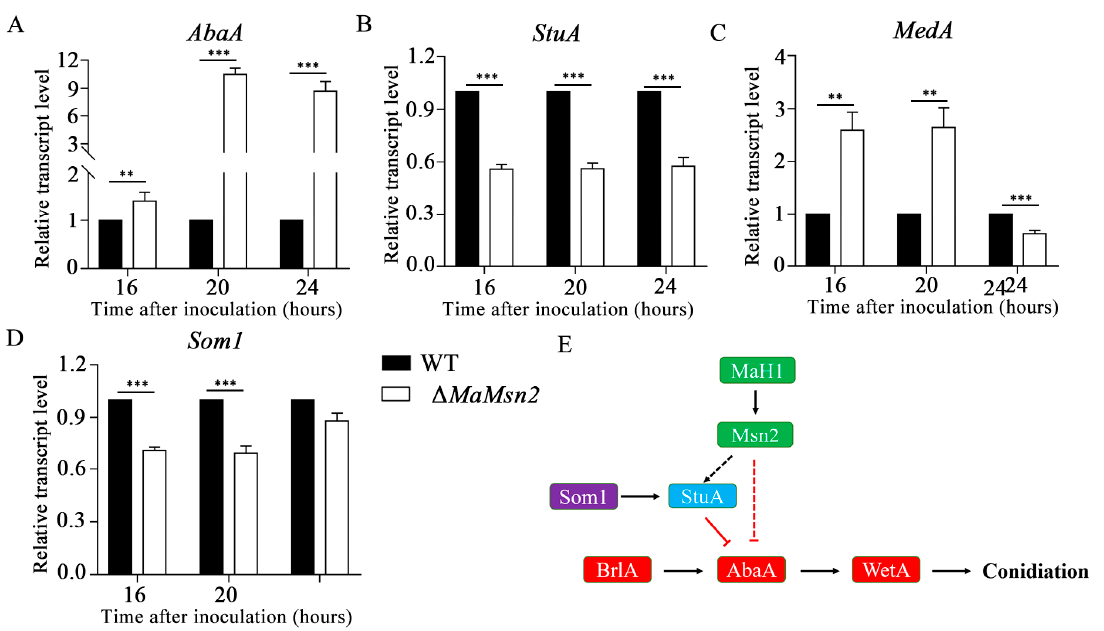
Figure 8. MaMsn2 regulates AbaA and StuA . ( A – D ) The relative expressions of conidiation-related genes in ∆ MaMsn2 ( t -test, ** : p < 0.01, *** : p < 0.001). ( E ) Genetic model for MaH1 – MaMsn2 in conidiation pathway.